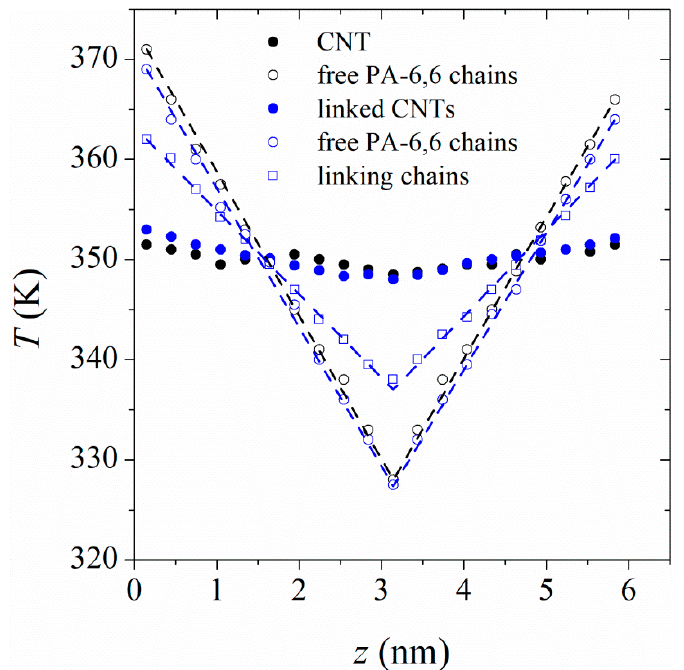
Figure 5. Temperature profiles for heat transfer in the parallel, to the CNT (17, 0) axis, direction. The filled and open markers represent the temperature profile in the CNT and in polymer, respectively. The black symbols belong to the case in which the free PA-6,6 chains are in contact with a single CNT. The blue markers represent a system in which free PA-6,6 are in contact with 4 CNTs linked together with PA-6,6 linkers (linkage fraction = 0.042).